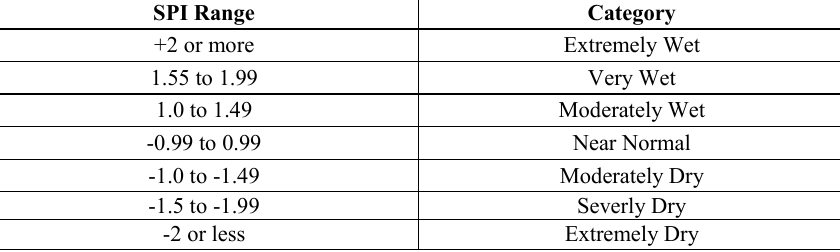
Table 1 . Standard Precipitation